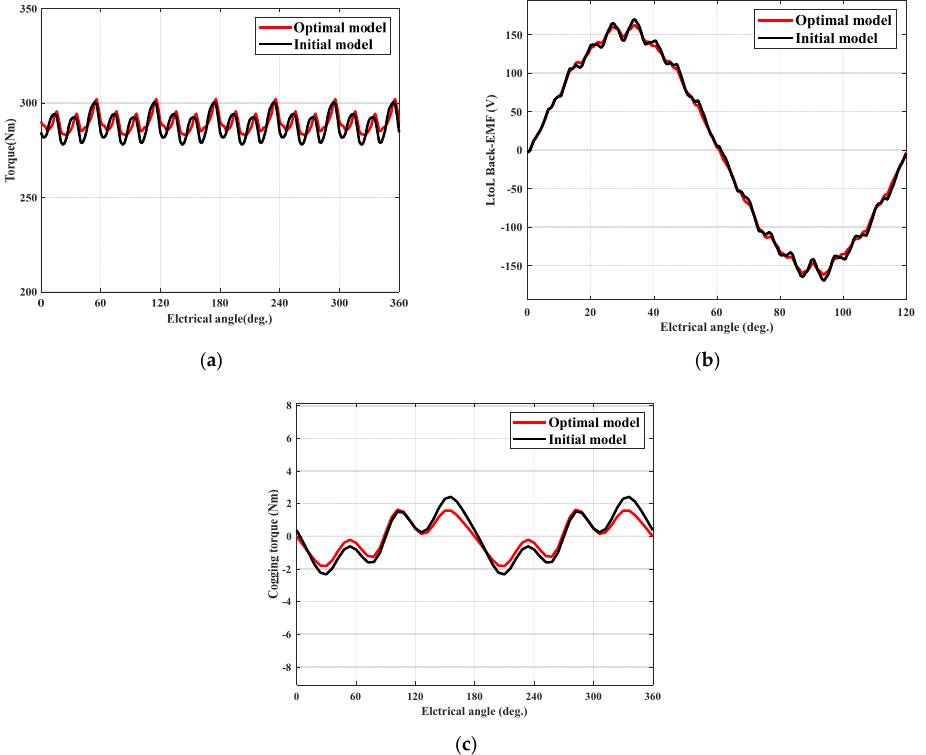
Figure 12. Comparison of initial model and optimal model. ( a ) Torque; ( b ) Back EMF; ( c ) Cog- ging